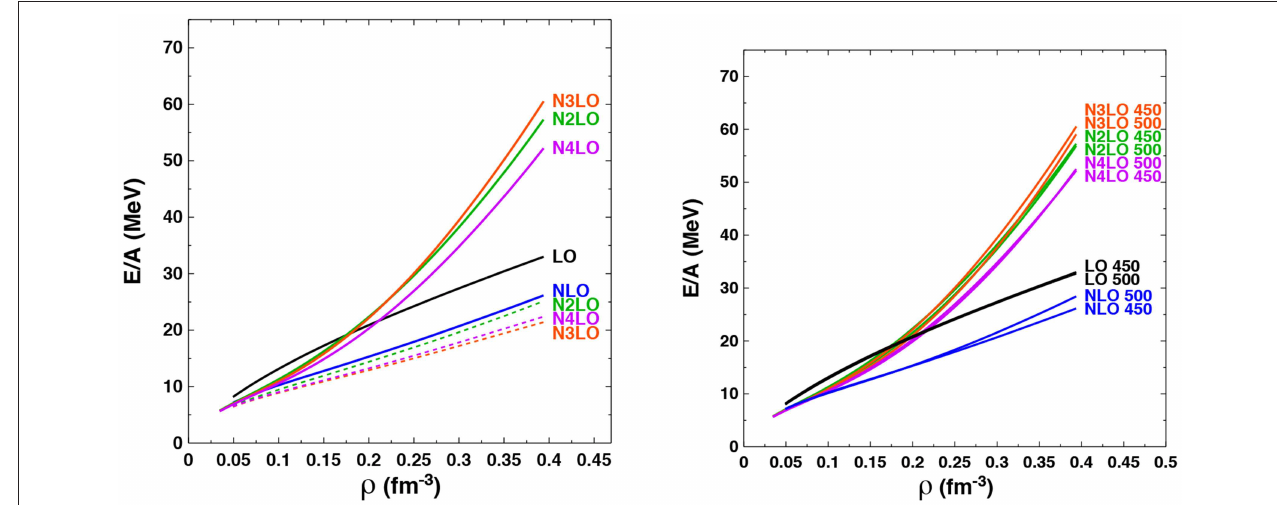
FIGURE 4 | (Left) Ground state energy per particle of NM as a function of density at the indicated orders in the chiral expansion. The three dotted curves show predictions including only the 2NF. The cutoff parameter is fixed at 3 = 450MeV and the 3NF LECs from Table 2 are used. (Right) Ground state energy per particle of NM as a function of density at the indicated chiral orders and with varying cutoff. The LECs of Table 2 are used.